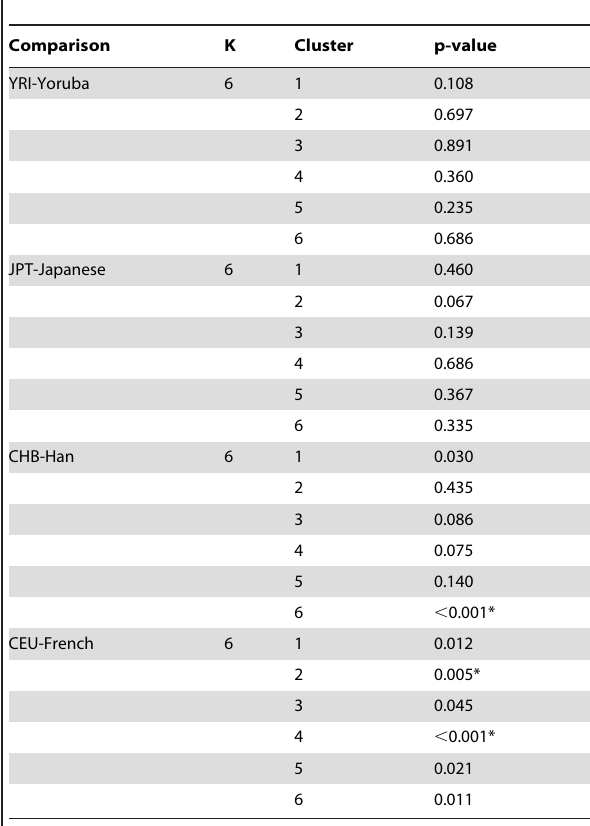
Table 1. Comparison of frequencies of genetic clusters identified by STRUCTURE (K =6) in HapMap samples and the most similar HGDP-CEPH